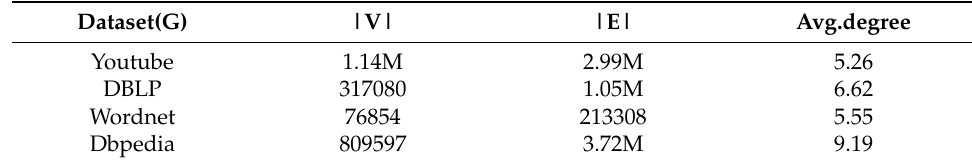
Table 1. Statistics of real datasets.